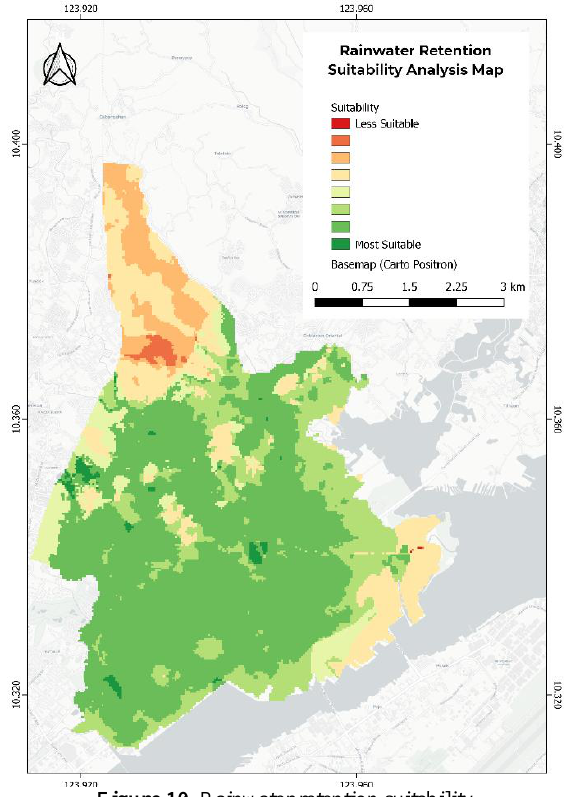
Figure 10. Rainwater retention suitability